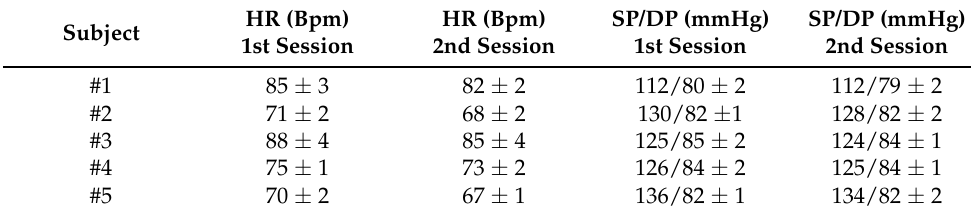
Table 1. Average values of vitals acquired in two sessions with related 1- σ